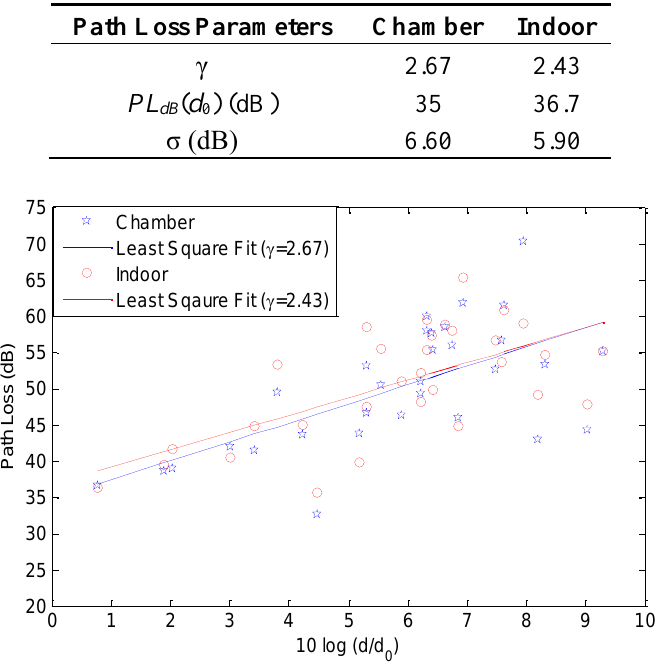
Table 3. On-body path loss parameters at 2.45 GHz.